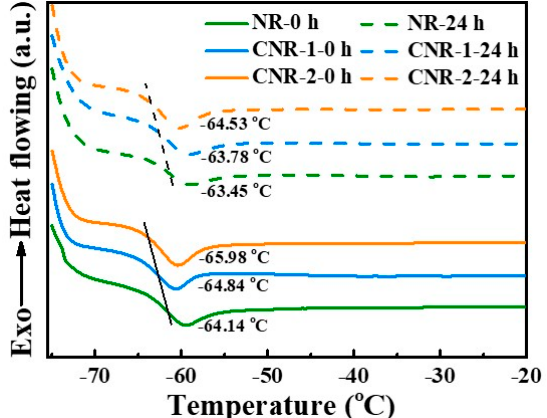
Figure 9. T g (glass transition temperature) of NR, CNR-1, and CNR-2 before and after accelerated storage.